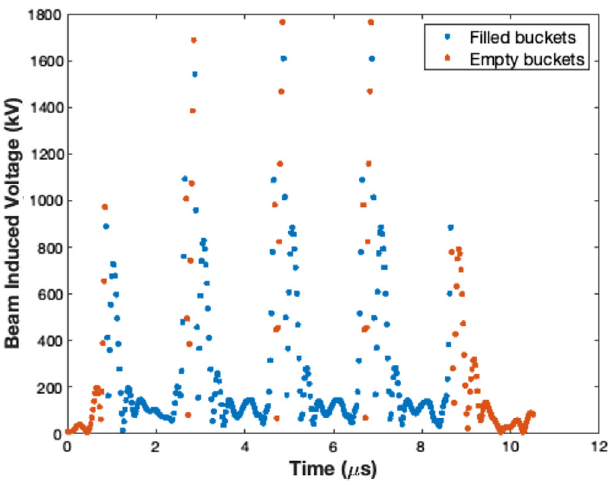
FIG. 22. Induced voltage with proposed